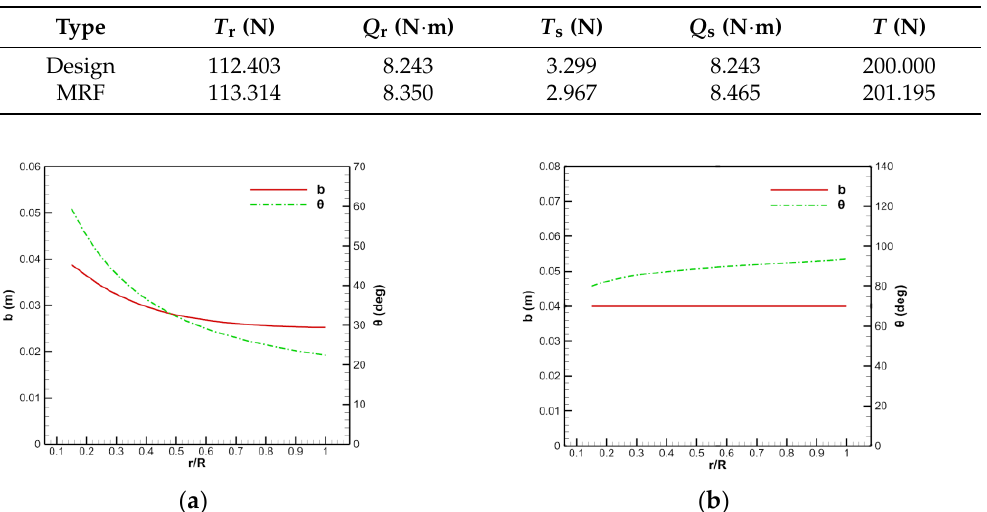
Table 6. Performance comparison of the 400 ducted fan.